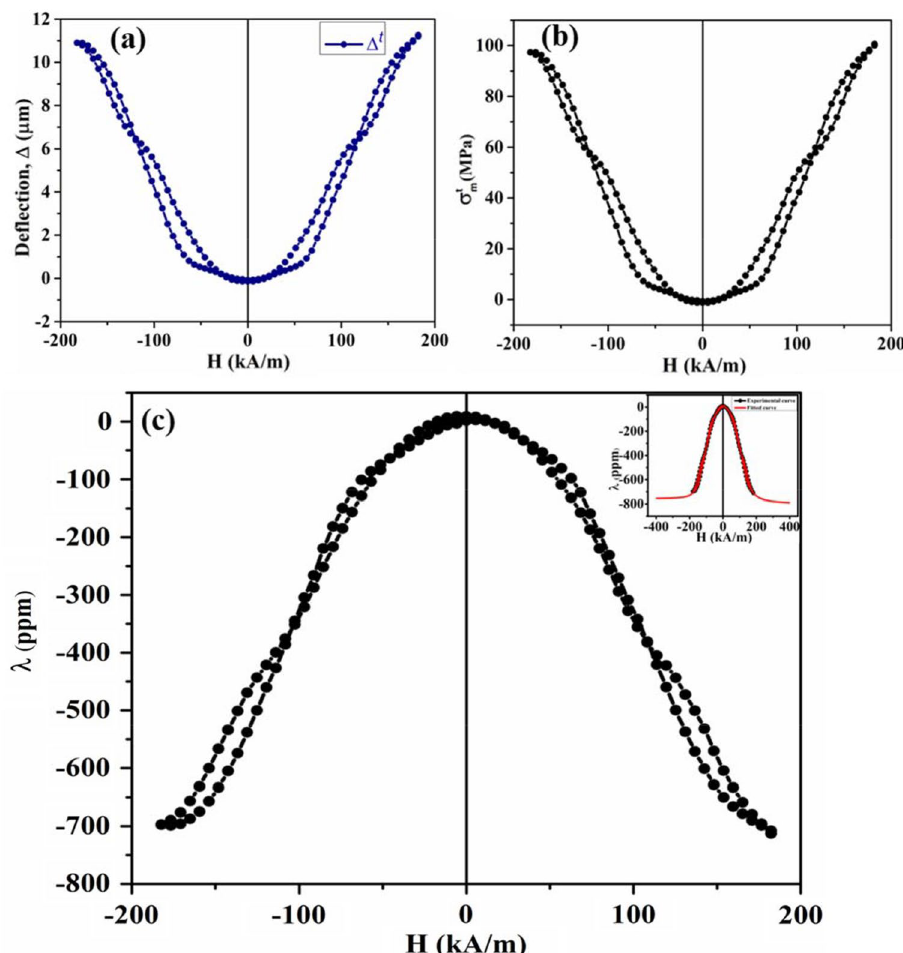
Figure 3. ( a ) The plot of cantilever deflection versus the applied magnetic field of CFO/Si. ( b ) The variation of out-of-plane magnetostrictive stress with the magnetic field. ( c ) The out-of-plane (λ ‒ H) plot, inset shows the fitted and extrapolated curve along with the experimental